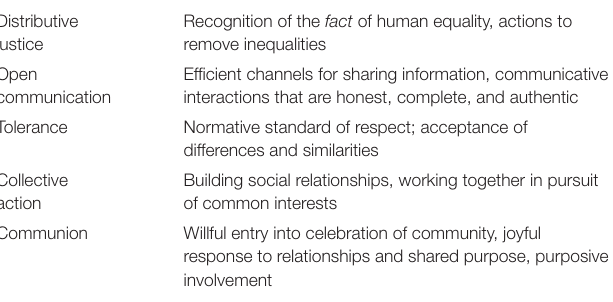
TABLE 1 | Dimensions of social well-being adapted from Wilkinson